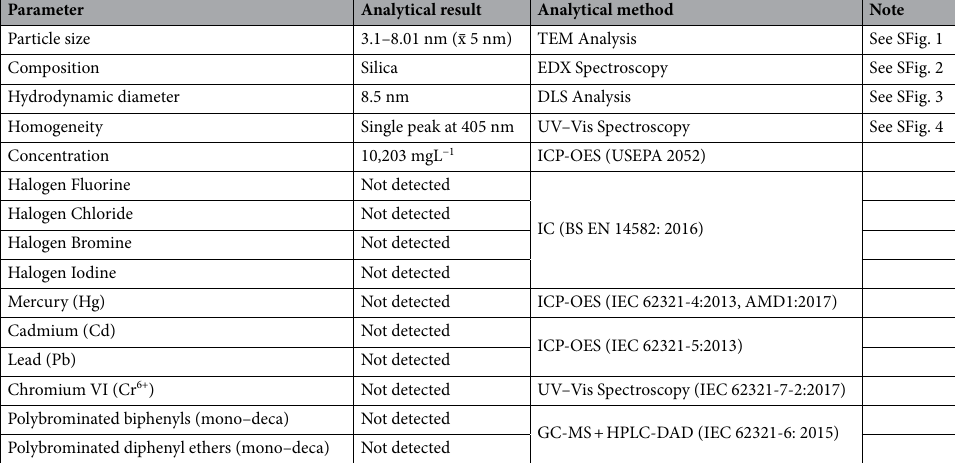
Table 1. Characterization of silver nanoparticles used in this